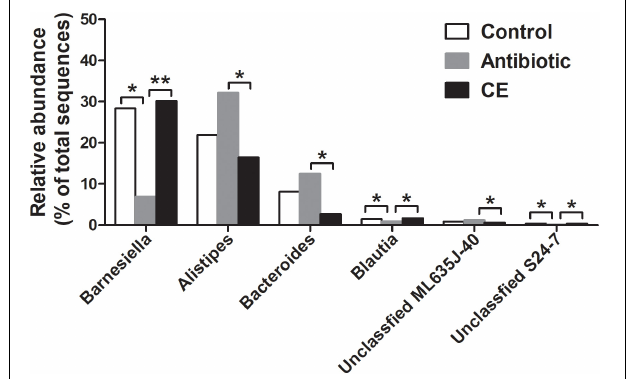
FIGURE 2 | Significantly changed bacteria genera by citrus extract treatment. The values were expressed as the medians ( n = 6). Asterisks indicate statistical differences between different groups (Kruskal–Wallis test): ∗ FDR-adjusted P value < 0.05; ∗∗ FDR-adjusted P value < 0.01. CE, citrus extract; FDR, false discovery